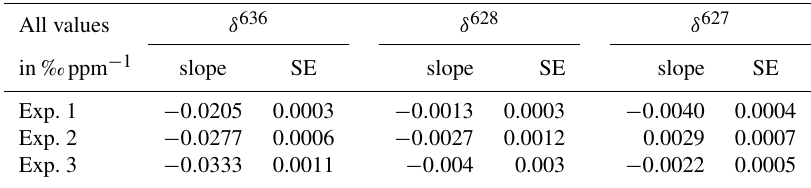
Table 2. Slopes derived from the linear fits of the three measured deltas and CO 2 mole fractions and the standard errors of the slopes. Delta values calculated with Eq. (4).